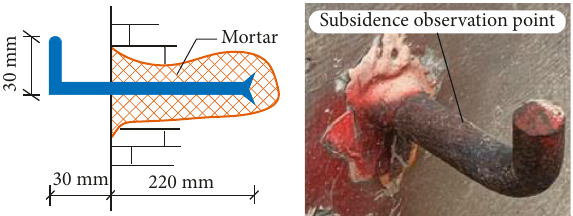
Figure 7: Layout method and physical map of building foundation settlement monitoring points.